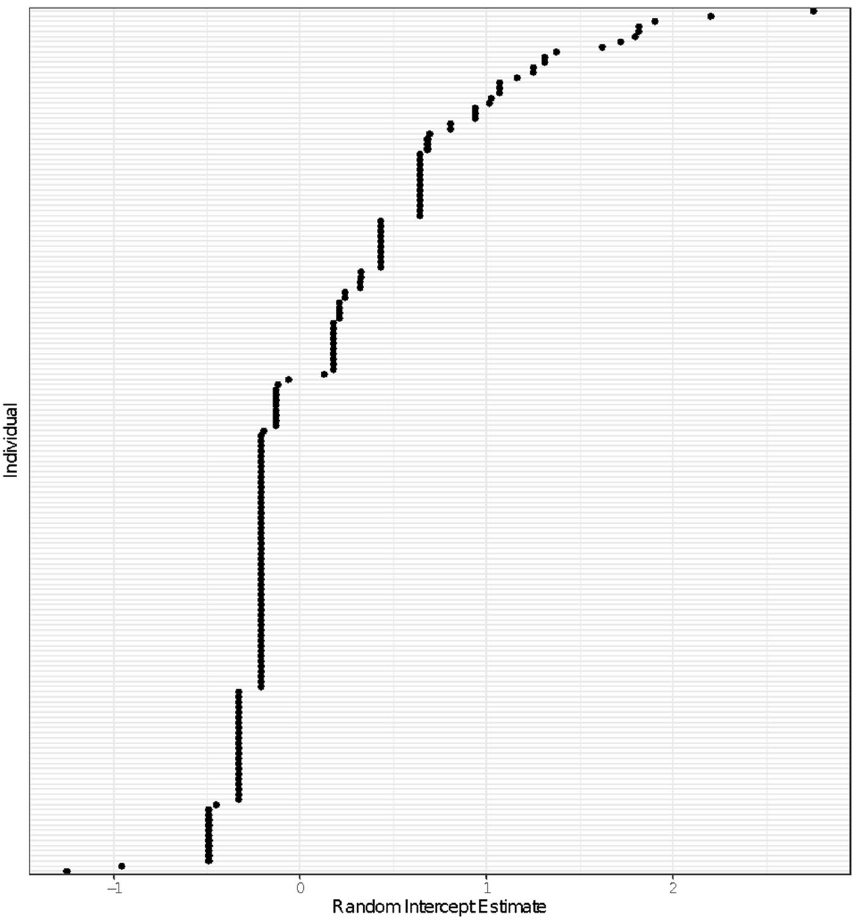
Figure 2. Estimate of random intercept for each individual seal (n = 170) based on the full model of best fit. The variability in random intercepts for each individual seal illustrates the importance of including ID as a random factor in the